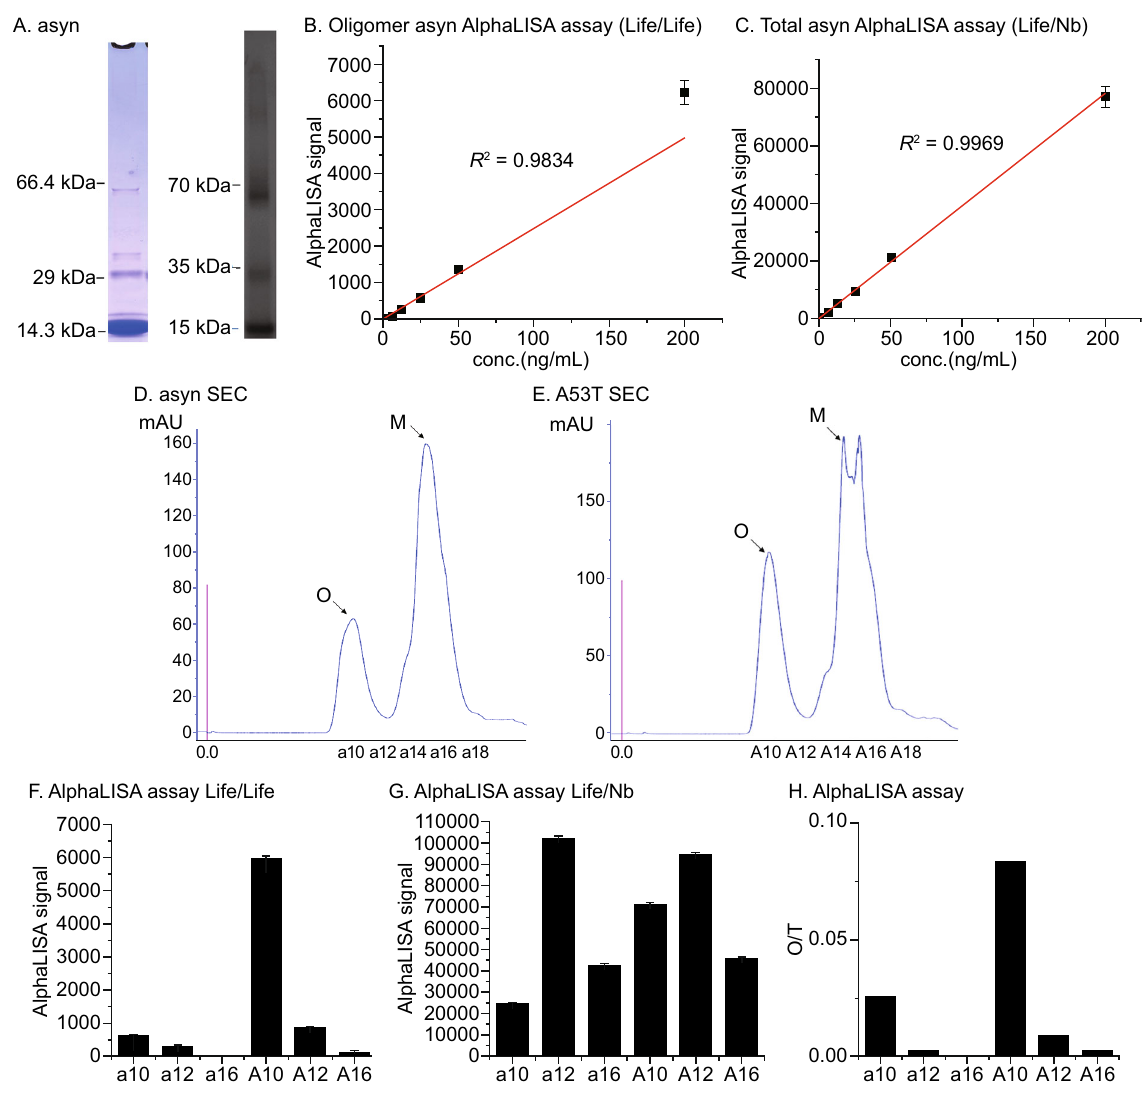
Figure 1. Development of AlphaLISA assays for detection of oligomeric and total α -syn . (A) Coomassie staining (blue) and Western-blot (dark, using Life antibody) analysis of recombinant puri fi ed α -syn, which contains both monomeric and oligomeric α -syn. (B) AlphaLISA assay of the puri fi ed protein in (A) uses the Life /Life antibody pair. The protein was tested at different concentrations indicated in the X-axis and the signals were fi tted with Y = kX. R 2 indicates the regression parameter. (C) Similar as (B), but using the Life/Nb antibody pair. (D) α -Syn protein was separated from oligomeric α -syn and monomeric by SEC. (E) Similar as (D), but using A53T protein. (F) The Life/Life antibody pair AlphaLISA detection of the indicated α -syn protein samples from SEC at 1 μ g/mL on 384-well microtiter plates ( n = 3). The monomeric samples a12 & a16, A12 & A16 generated much smaller signals compared to oligomeric samples a10 and A10. (G) Similar as (F), but using the Life/Nb antibody pair. All samples gave signals. (H) The ratio between Life/Life signals and the Life/Nb signals was calculated for the AlphaLISA assay, and this ratio (O/T) separates oligomeric and monomeric samples. For Figure 1B – G, plots indicate mean ± SEM, and n =